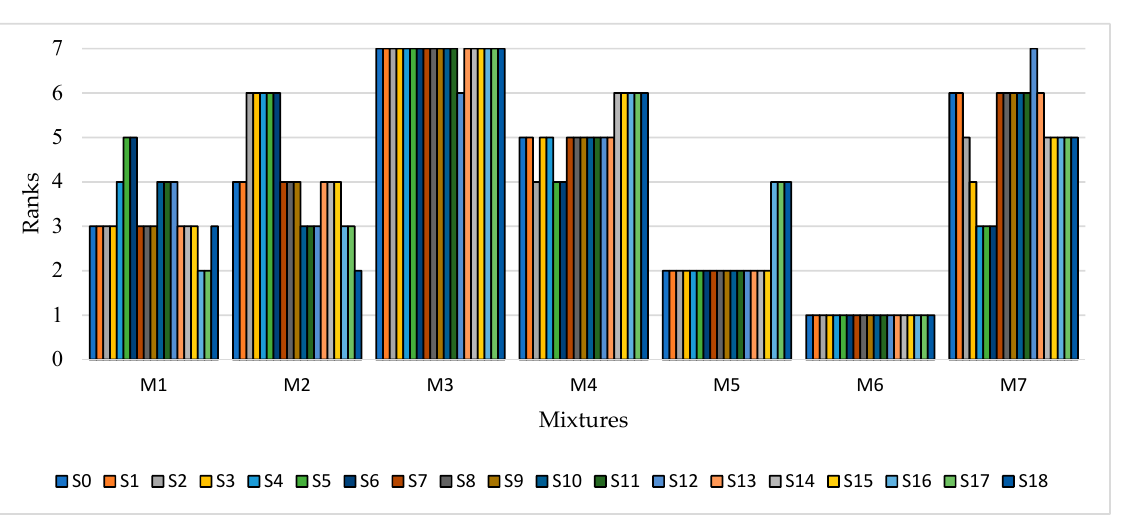
Figure 8. Result of sensitivity analysis.